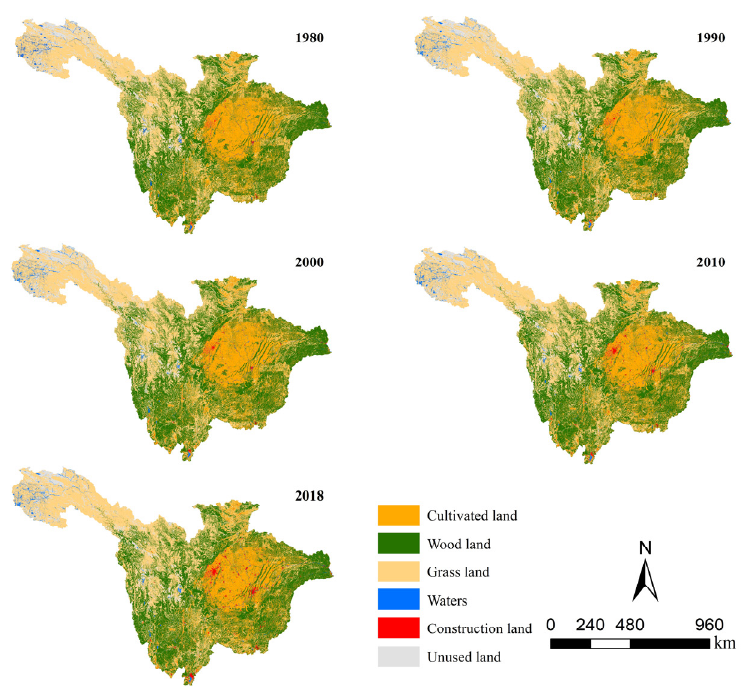
Figure 11. Structure of land use types in the upper Yangtze River from 1980 to 2018.